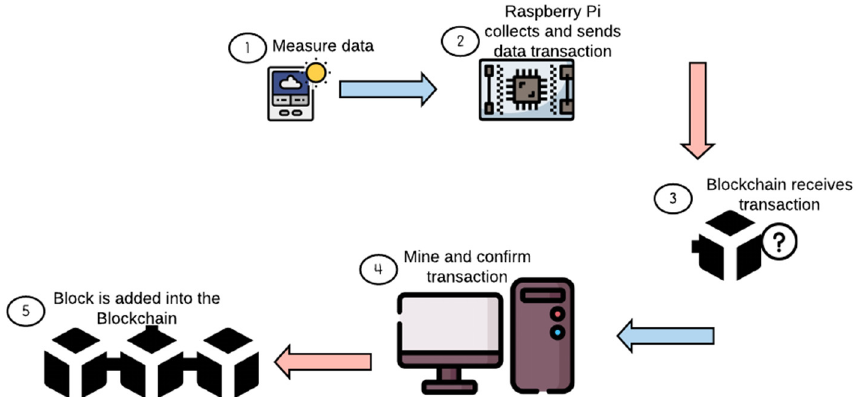
Figure 3. Steps to store sensor data in Ropsten as performed in our experiments.